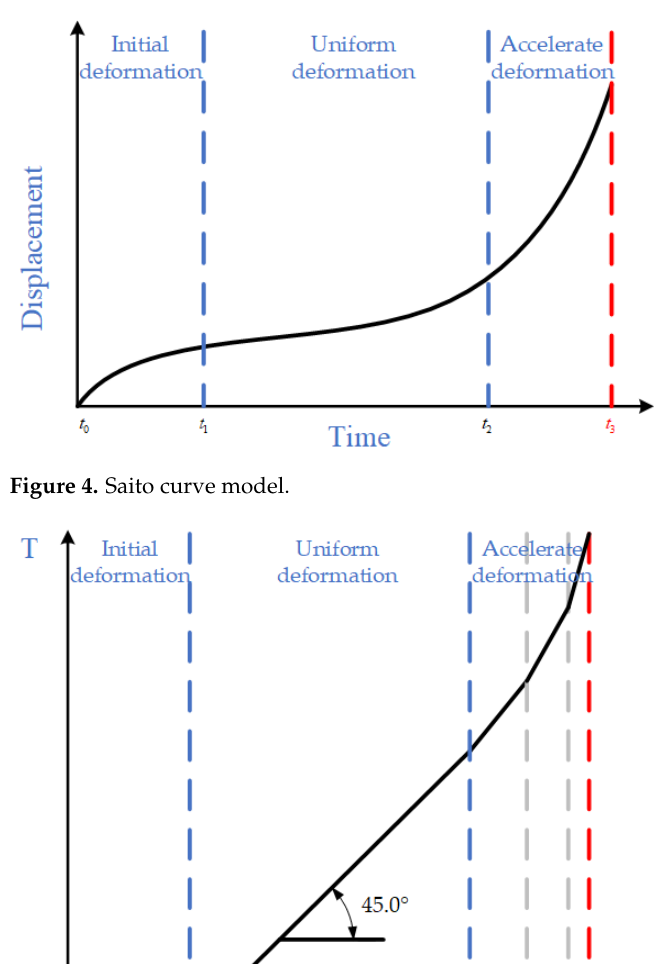
Figure 3. Radar image of monitored scene.